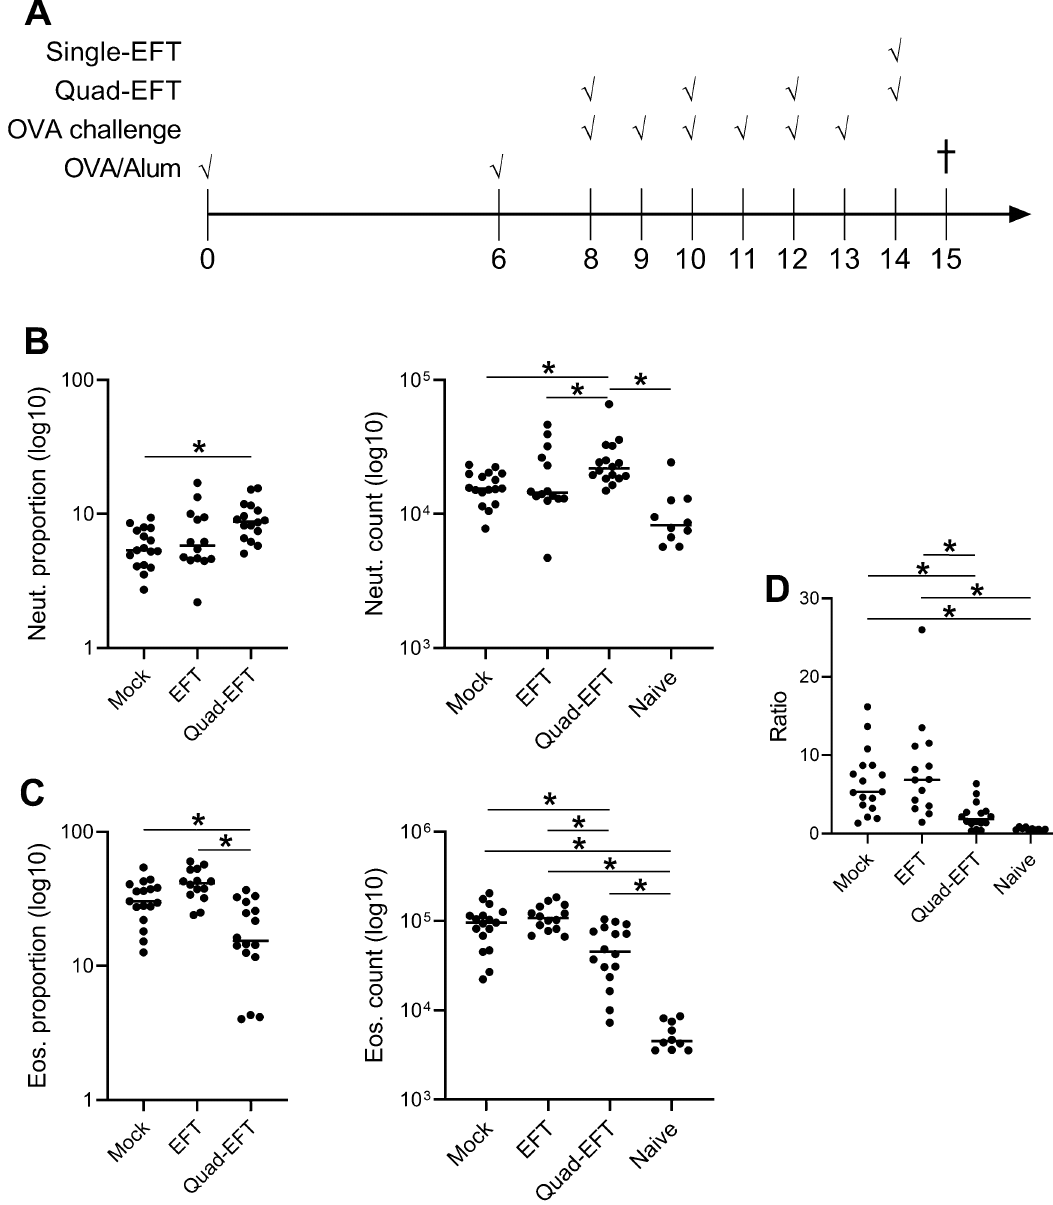
Figure 4. EFT-induced changes in lung immune cell infiltrates in a model of allergic airways inflammation. ( A ) Experiment time line. All mice except naïve were sensitized with OVA in aluminum hydroxide by intraperitoneal injection and then challenged with OVA by intranasal administration for 6 consecutive days starting at day 8. EFT was given as a single dose at day 14, or in four doses at days 8, 10, 12, and 14 (Quad-EFT) immediately prior to OVA challenge. Mock was performed at the same time points as Quad-EFT. Endpoint analyses occurred on day 15. Lung ( B ) neutrophil and ( C ) eosinophil proportion of total CD45 + cells (left graphs) and counts (right graphs) and ( D ) eosinophil:neutrophil ratio were determined by flow cytometry across 3 independent experiments, n = 14–17 per group. Lines show group median with individual mice shown as points. * p < 0.05 by